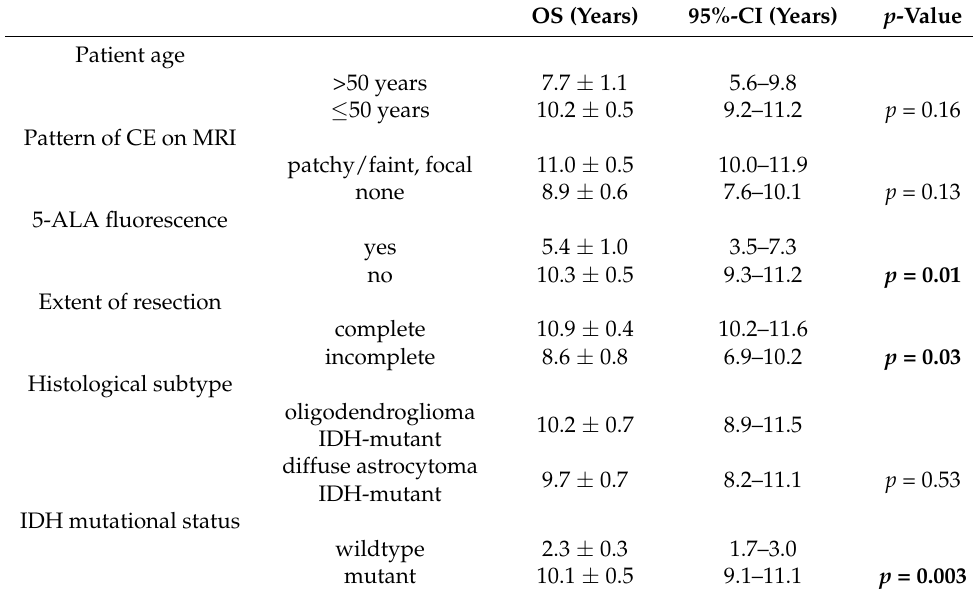
Table 4. Overall